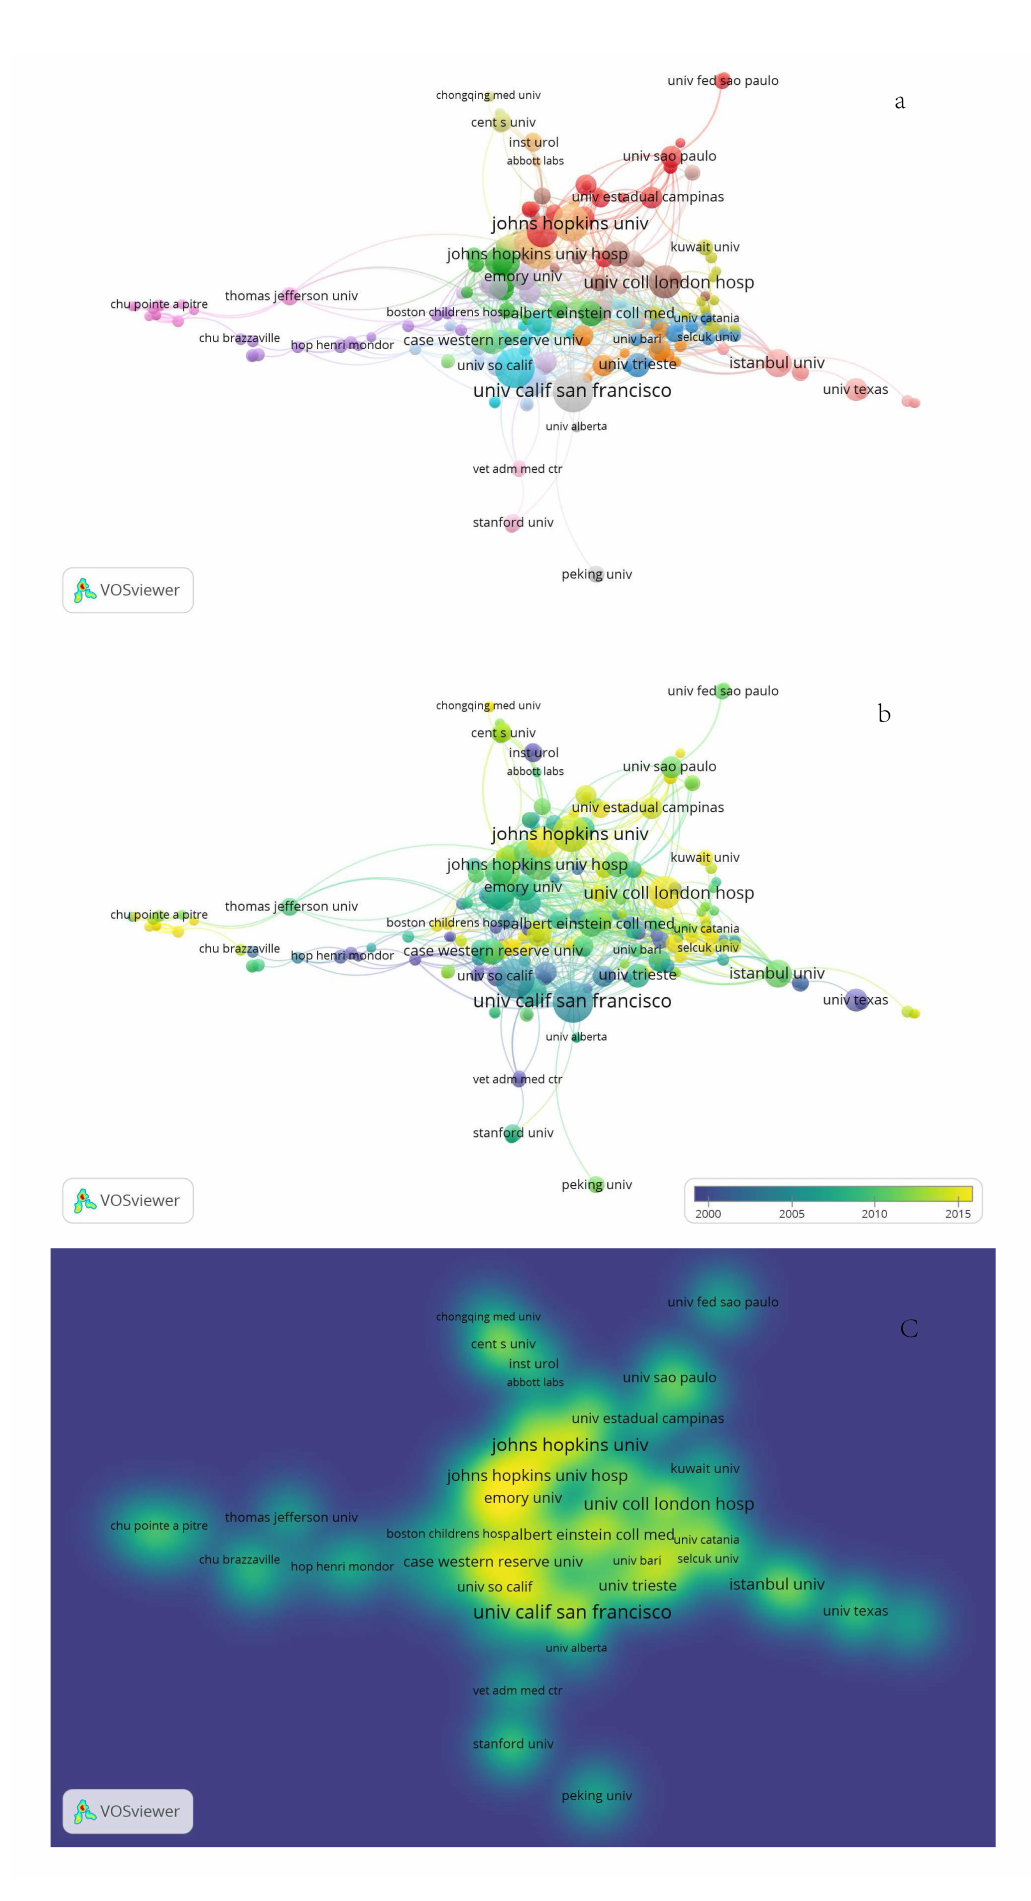
FIGURE 3. The font size of each institution represents the number of publications in the institutions. The thickness of the lines indicates the strength of the connection. a, the institutions collaboration network of research on priapism. b, different colors inside the circle represent different time intervals. c, the brighter the color, the more publications for